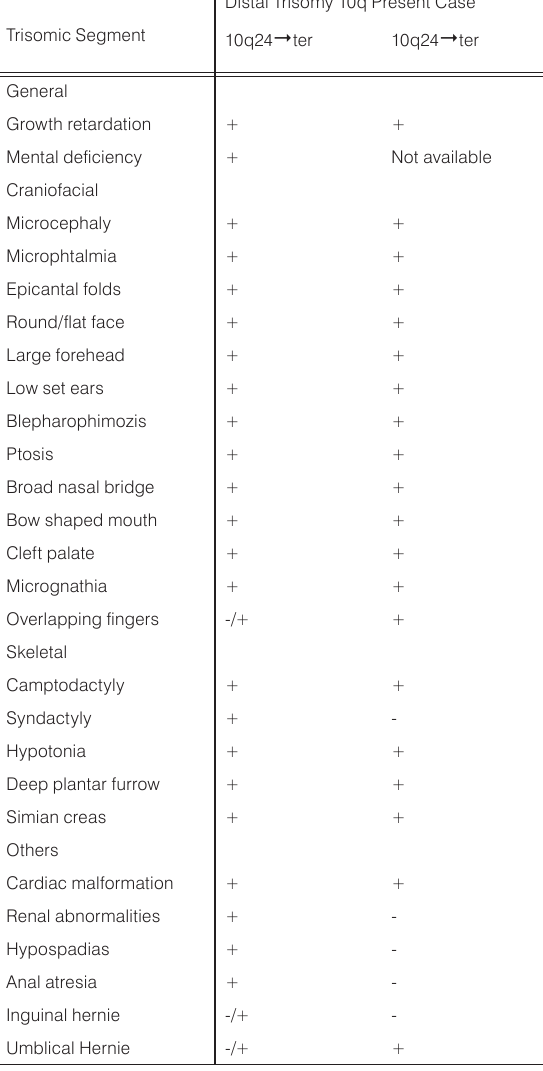
Table 1. Comparison Between Distal Trisomy 10q Syndrome and Present Case Distal Trisomy 10q Present Case